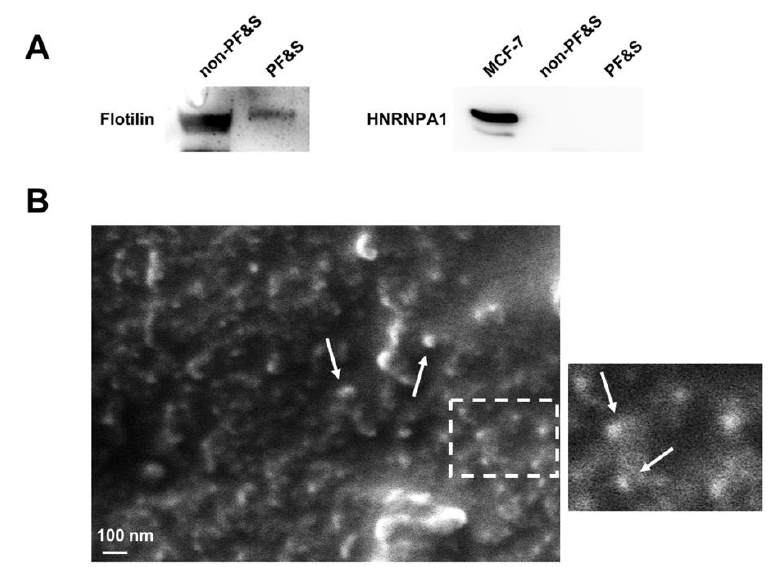
Figure 1. ( A ) Blots of the cytosolic protein flotilin and heterogeneous nuclear ribonucleoprotein A1 (HNRNPA1) as positive and negative markers respectively, in purified small extracellular vesicles (sEVs) obtained by serum ultracentrifugation from participants with physical frailty and sarcopenia (PF&S) and non-physically frail non-sarcopenic (non-PF&S) controls. The Michigan Cancer Foundation-7 (MCF-7) cell extract was used as the positive control for the anti-HNRNPA1 antibody. ( B ) Scanning electron micrographs of purified sEVs. The white-dashed box delimitates the area zoomed on the right. White arrows indicate some of the sEVs found in the observation field. Scale bar: 100 nm.